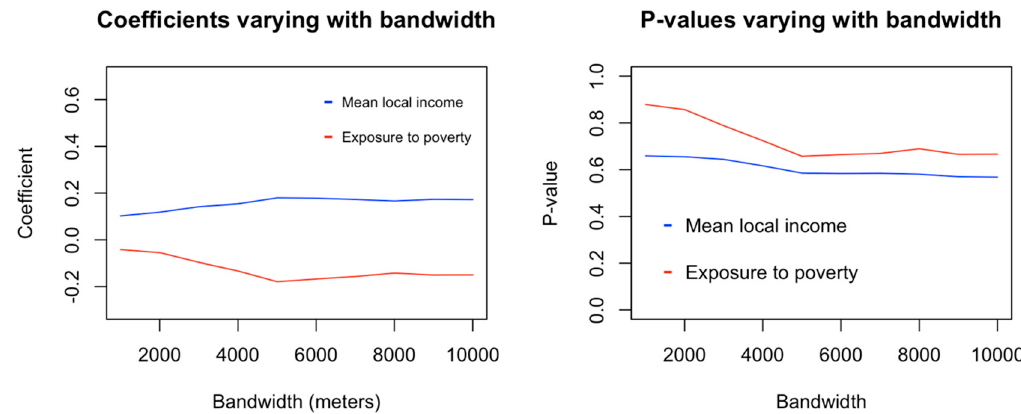
Figure 8. Coefficient values ( left ) and their significance ( right ) varying with bandwidth for the case of burglary risk at apartments.